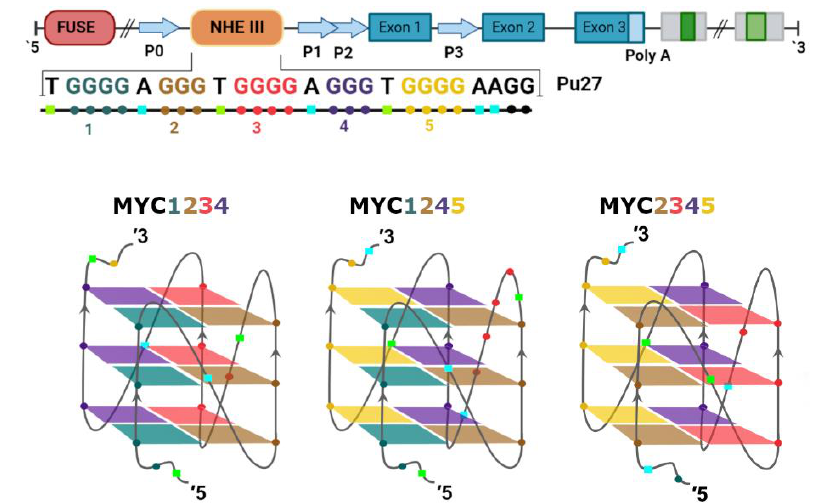
Figure 2. Pu27 c-MYC sequence ( top ) and representation of different guanine combinations to form different G-quadruplexes ( bottom ).